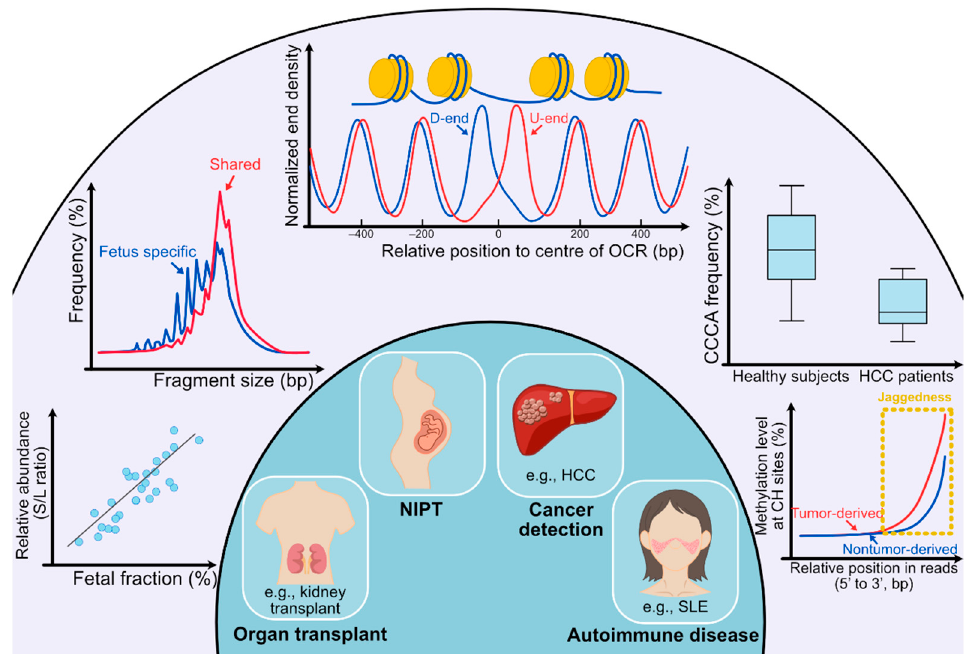
Figure 2. Clinical utilities of cell-free DNA fragmentomics. (Outer circle) In the outer circle, several analyses of cfDNA molecules are listed. From left bottom to right bottom, the first analysis shows the analysis concerning preferred ends. ‘S’ stands for preferred end sites for short fragments (60–155 bp) and ‘L’ stands for preferred end sites for long fragments (170–250 bp). A positive correlation can be observed between the relative abundance of fragments with set S versus set L preferred end sites (denoted as the S/L ratio) and the fetal DNA fraction. The second analysis shows that the size of fragments with fetal-specific single nucleotide polymorphisms (SNPs) is generally shorter than that of shared alleles. The third analysis is for deducing tissues of origin. Fragments released from different tissues show diverse nucleosomal positioning patterns, which can be represented by calculating the cumulative difference in normalized end density of U-ends and D-ends with 60 bp away from the center of the open chromatin regions (OCR) in different directions. In the fourth analysis, the frequency of CCCA, which is the end motif of the highest frequency in healthy human subjects, significantly decreases in HCC patients. For the fifth analysis, the methylation level at CH sites gradually increases as the CH sites are closer to the 3’ end of the fragments, and the increase in tumor-derived DNA molecules overtakes fragments carrying wild-type alleles. Such an increase in methylation level is because of the presence of jagged ends on plasma DNA molecules, which incorporates methylated cytosines during the DNA end-repair process. The tumor-derived DNA molecules would carry relatively more and longer jagged ends. (Inner circle) In the inner circle, four main applications (organ transplantation, NIPT, cancer detection, and autoimmune disease) are implicated by analyses of fragmentation patterns of cfDNA molecules.